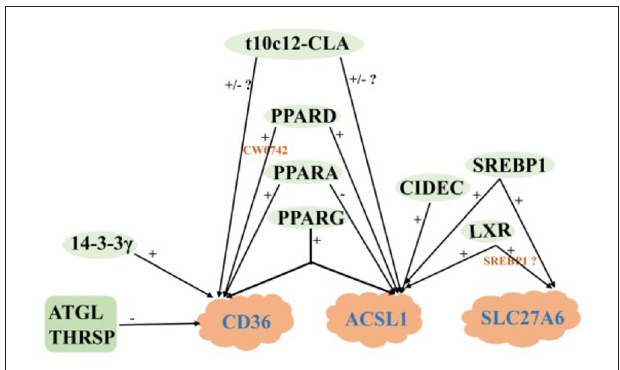
FIGURE 3 | Regulatory network of LCFA uptake and activation in ruminants. + : Positive regulation; –: Negative regulation.